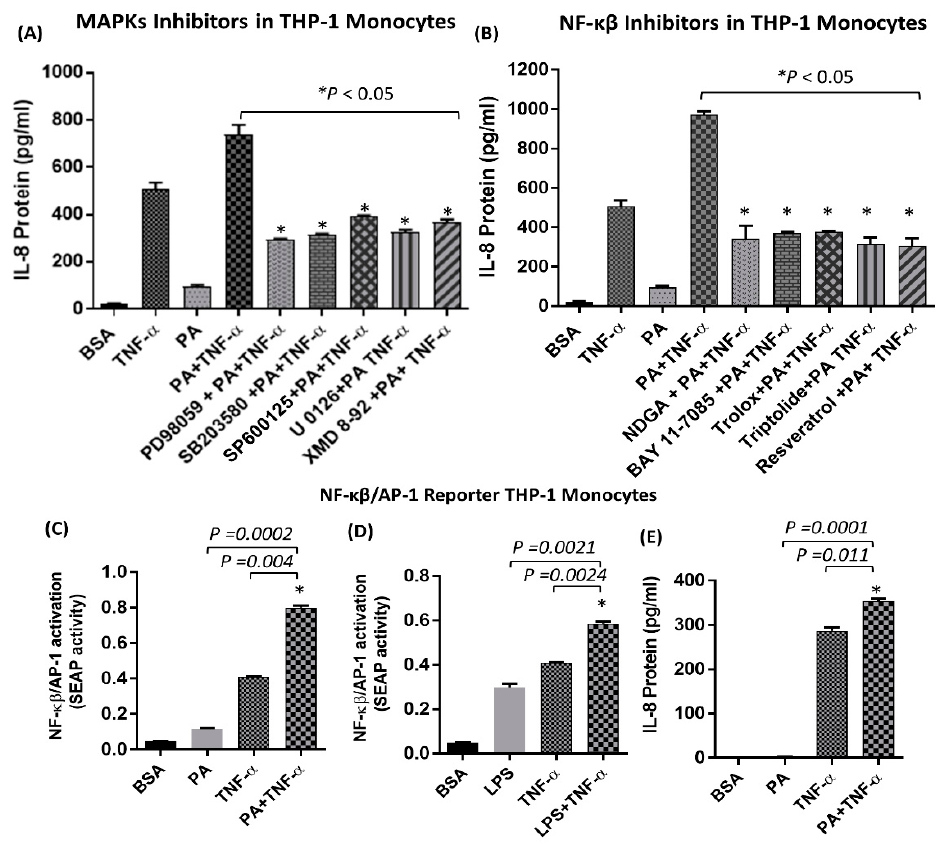
Figure 4. MAPKs and NF- κβ pathways are required for the synergistic production of IL-8 by palmitate / TNF- α . ( A )Cellswerepretreatedwithmitogenactivatedproteinextracellularsignal-regulated kinase (MEK)-ERK inhibitors (U0126: 10 µ M; PD98059: 10 µ M) or JNK inhibitor (SP600125: 20 µ M) or p38 inhibitor (SB203580: 10 µ M) or MEK5 / ERK5 inhibitor (XMD 8-92: 1 µ M) or for 1 h and then treated with PA and TNF- α alone or both for 24h. Secreted levels of IL-8 protein were quantified in culture supernatants by ELISA. ( B ) Cells were pretreated with NF- κβ inhibitors (Trolox, 10 µ M; NDGA, 10 µ M; BAY 11-7085, 10 µ M; Triptolide, 10 µ M; Resveratrol, 5 µ M) for 1 h and then treated as indicated for 24h. Secreted levels of IL-8 protein were quantified in culture supernatants by ELISA. ( C – E ) THP1-XBlue cells (monocytic cells stably expressing a secreted embryonic alkaline phosphatase (SEAP) reporter inducible by NF- κβ and AP-1) were treated with PA and LPS, alone or in combination with TNF- α , for 24 h. Cell culture media were assayed for IL-8 protein as well as SEAP reporter activity (degree of NF- κβ / AP-1 activation). The results obtained from three replicates of each experiment are shown. Data are presented as mean ± SEM. * Indicates significant di ff